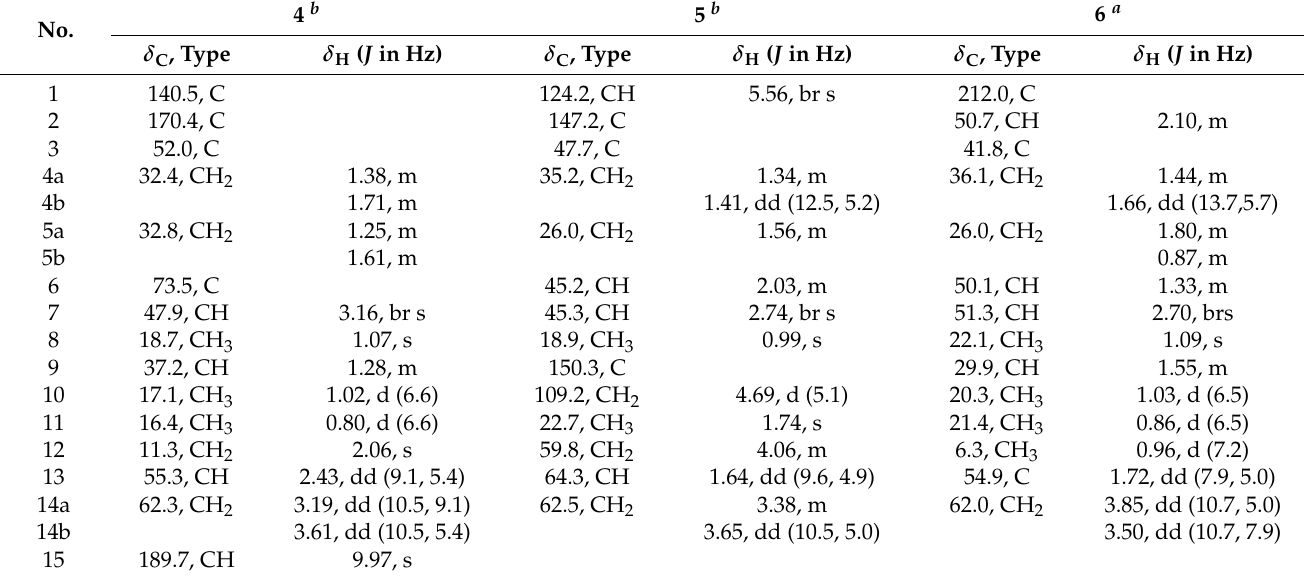
Table 2. 1 H (600 MHz) and 13 C (150 MHz) NMR Spectroscopic Data for 4 – 6 .